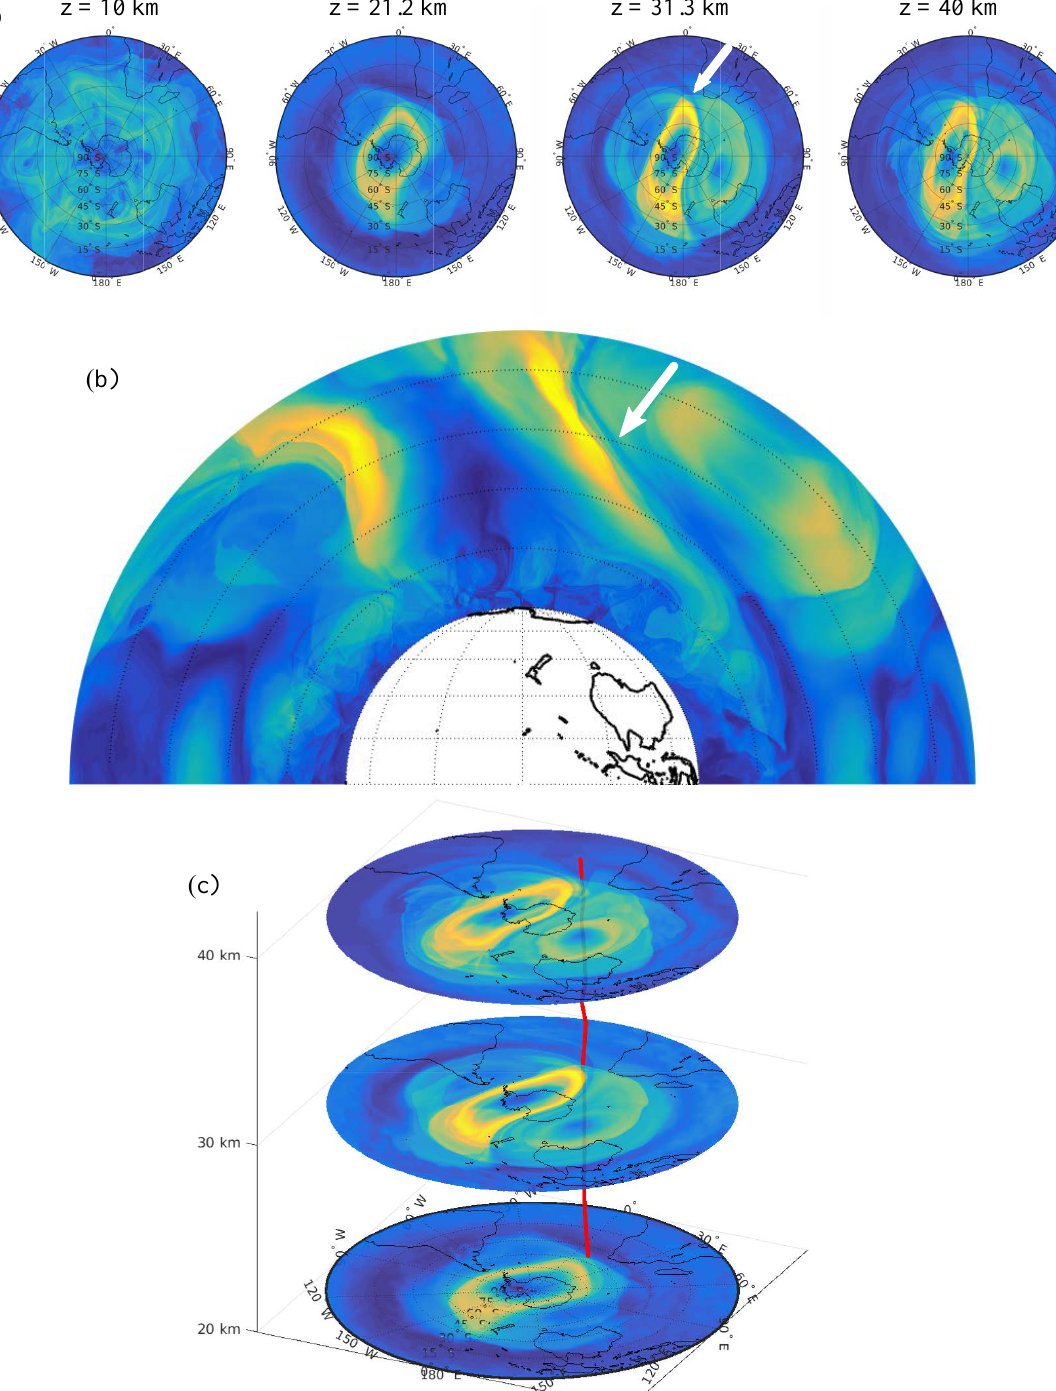
Figure 9. 6 October 1979 00:00:00UTC. (a) Slices of M at constant heights z = 10, 21.2, 31.3 and 40km with τ = 5; (b) slice of M at constant longitude λ = 90 ◦ W and λ = 90 ◦ E. (b) The black lines on the stratosphere correspond to heights 10, 20, 30 and 40km and black lines on the Earth’s surface correspond to latitudes 15, 30, 45, 60, and 75 ◦ S. (c) Slices of M at constant heights z = 21, 30, and 39km; the red line indicates the position of the hyperbolic point marked with a white arrow in panel (a) for different heights, i.e it is the normally hyperbolic invariant